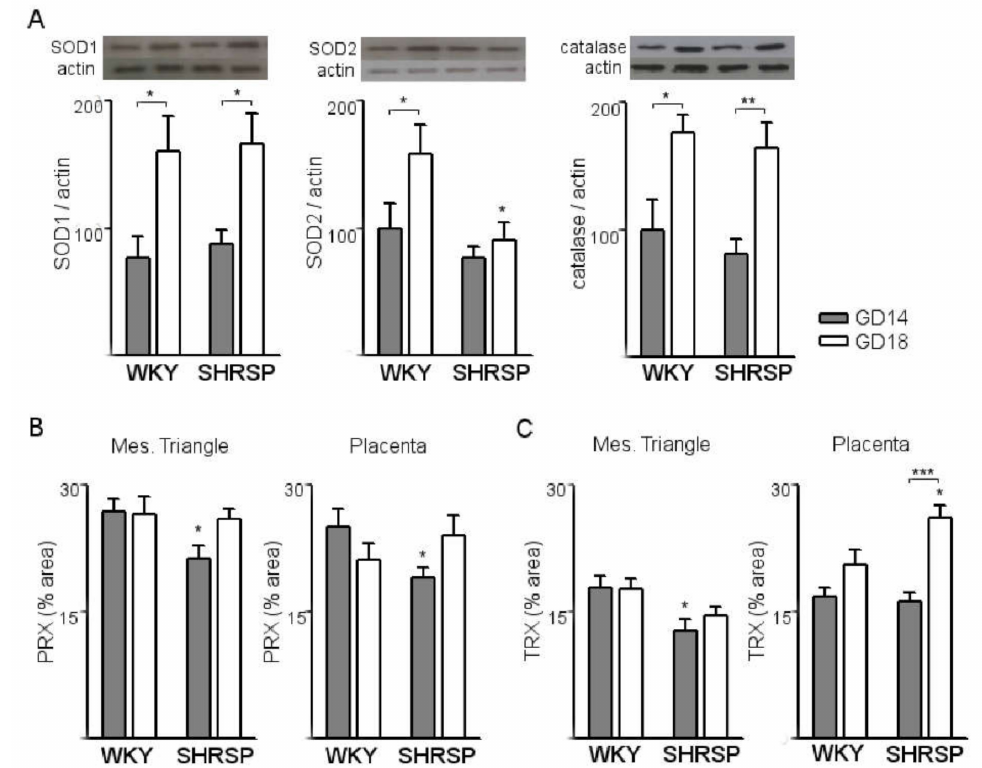
Figure 3. SHRSP placentas display defective expression of antioxidant systems. ( A ) Western blot analyses of the expression of ROS-detoxifying enzymes SOD1 (left panel), SOD2 (middle panel) and catalase (right panel) in WKY vs. SHRSP placentas. Normal upregulation of SOD2 expression towards GD18 was abrogated in SHRSP pregnancies. ( B ) Immunohistochemical analysis of PRX expression in both models. ( C ) Placental expression levels of TRX in both models as assessed by immunohistochemistry. The results are expressed as the means ± SEM, n = 5–7 animals/group. In all the panels, * p < 0.05, ** p < 0.01 and *** p < 0.001 as determined by two-way ANOVA and Bonferroni post-hoc